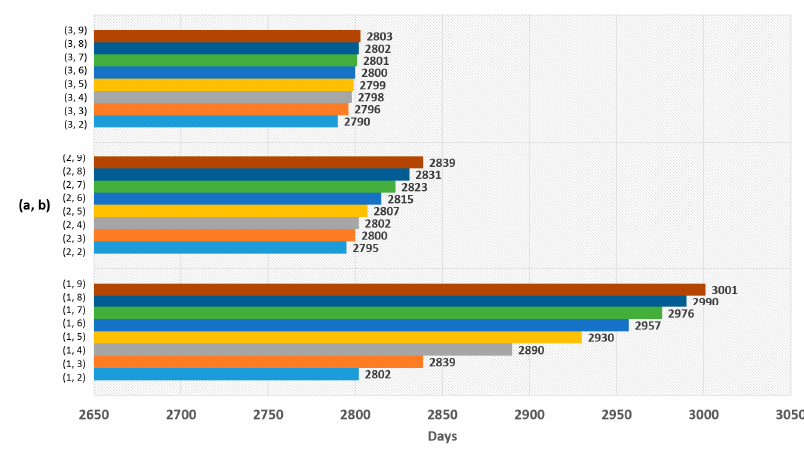
Figure 10. Data loss rate in case of using polynomial function with ‘a’ = 1.